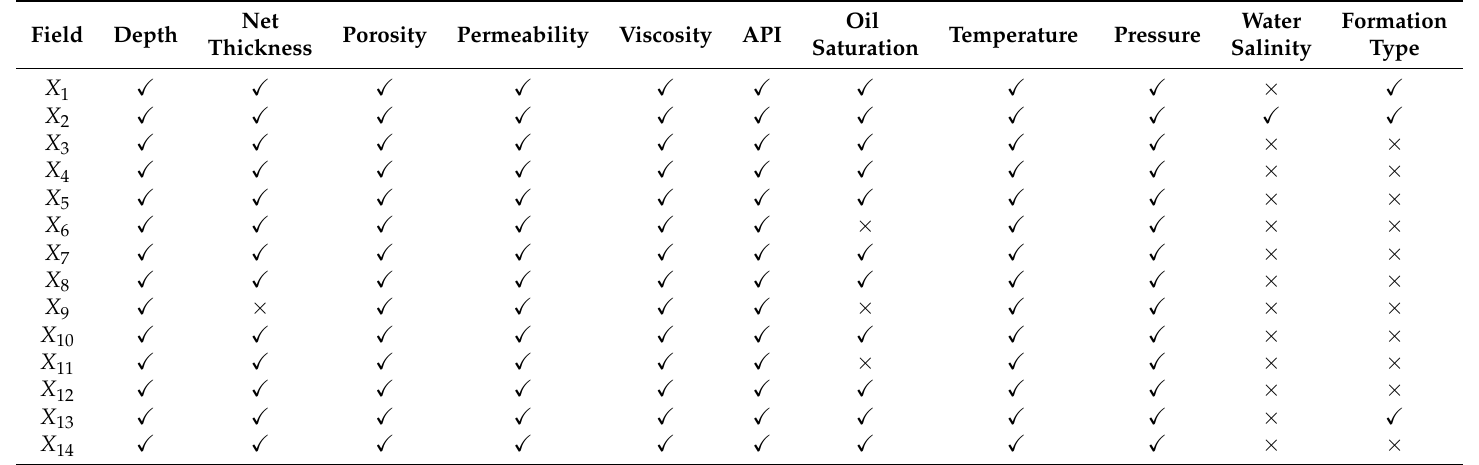
Table 3. Available data set by field. (Courtesy: Sonangol